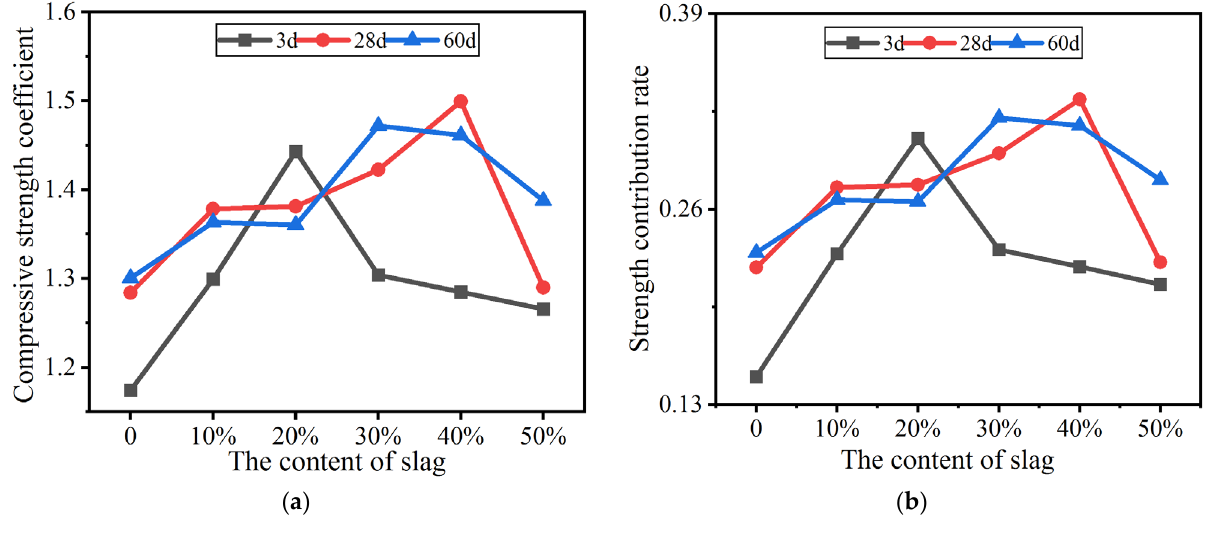
Figure 7. ( a ) Specific compressive strength coefficient of gangue – slag admixture; ( b ) Strength contribution rate of gangue – slag admixture.